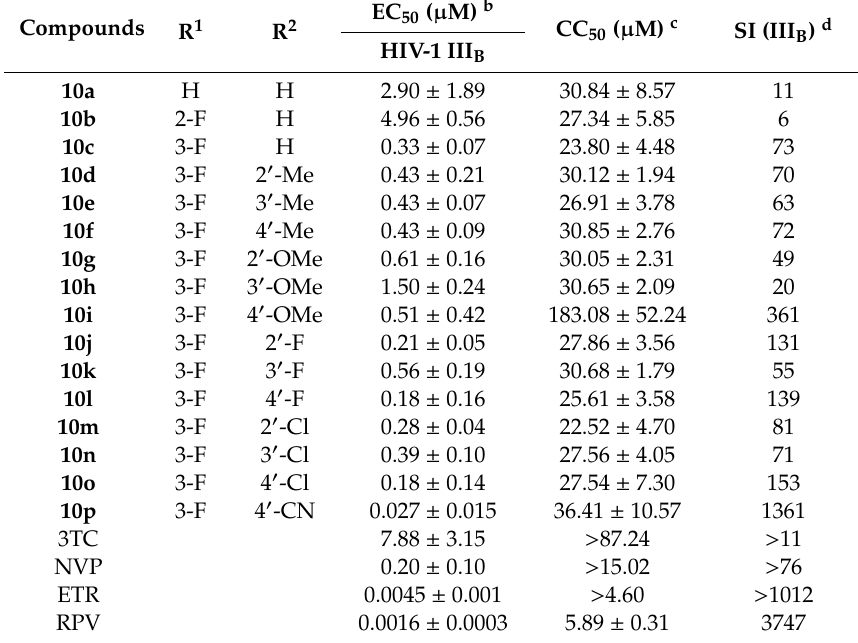
ff ective concentration 50 : e